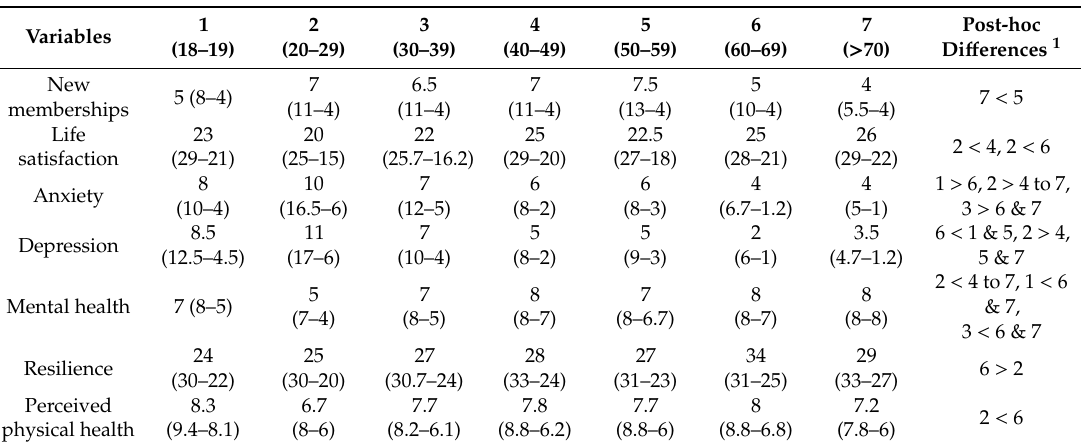
Table 3. Descriptives (Md (IQR)) and post-hoc di ff erences by age group.